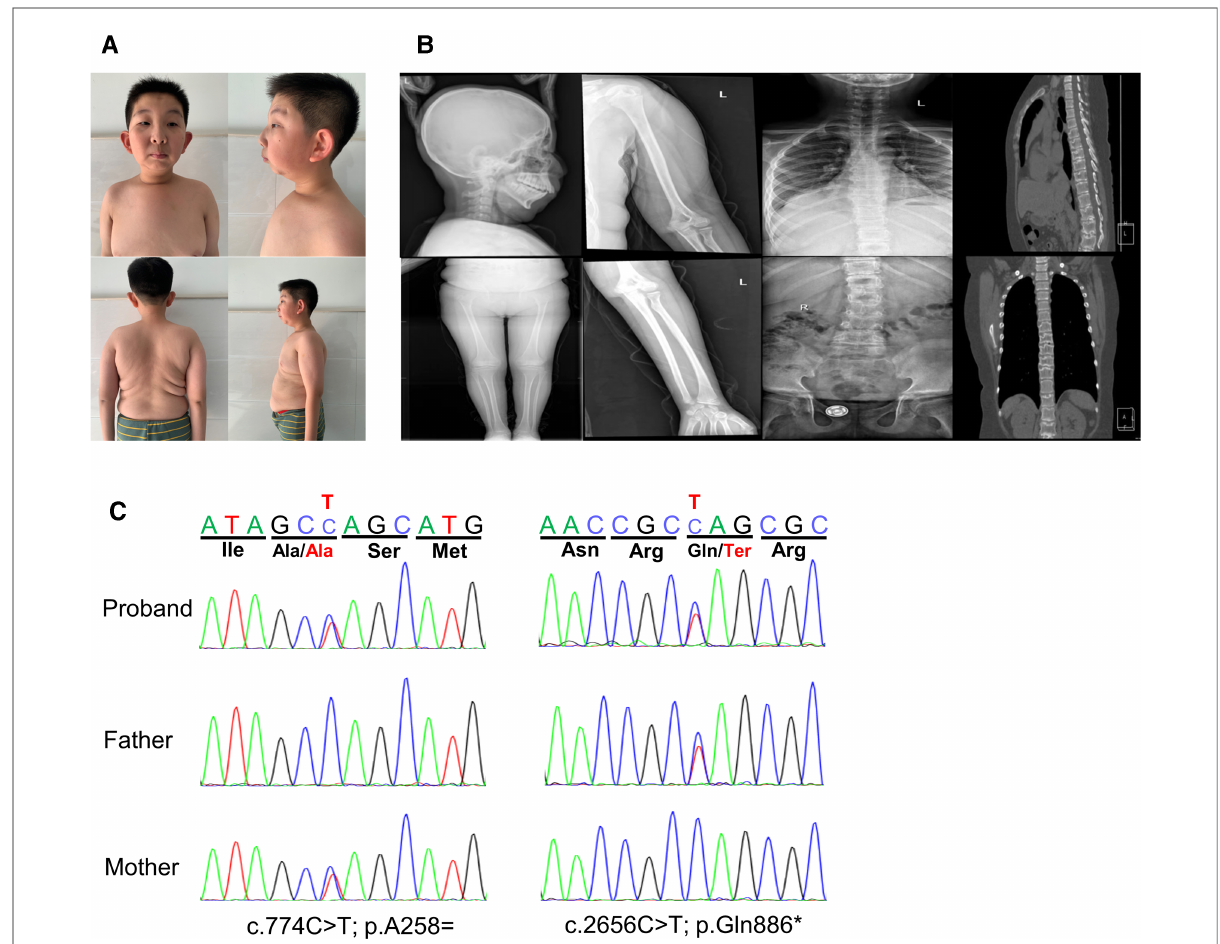
FIGURE 1 Clinical features and gene variants of the proband. ( A ) The patient exhibited dysmorphic facial features with high nose bridge, epicanthus, prominent cheekbones, retromicrognathia, big ears. Other features included pectus carinatum, scoliosis, large and protruding abdomen. ( B ) Radiographies showed multiple thoracolumbar vertebral bones dysplasia with scoliosis, the rough edges of vertebra, endplate bone defects, and the narrow intervertebral space, while no obvious abnormalities were seen in the long bones of limbs and the skull. ( C ) The compound heterozygous variants in the MBTPS1 gene detected in our patient. The two variants, c.774(exon6)C>T and c.2656(exon20)C>T, were inherited from her mother and father,